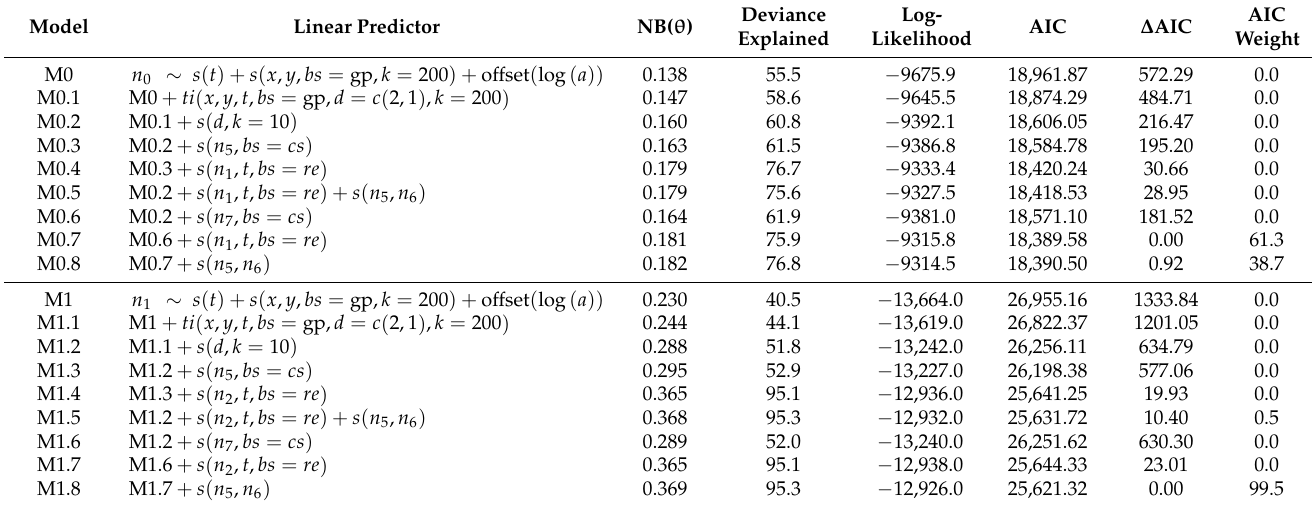
Table 2. Models evaluated to explain the number of Chilean hake juveniles of age groups 0 ( n 0 ) and 1 ( n 1 ), during the austral winter, between 1997 and 2018. The GAM model considered the negative binomial distribution and link log. The number of age 7 (n 7 ) is the number per unit area of 7-year-old and older adult hake. The nomenclature is t = year, x = longitude, y = latitude, a = swept area, and d = bottom depth. The GAM smother terms are explained in the text, and NB( θ ) is the estimated dispersion parameter of negative binomial distribution. The selected model is M07 and M1.8 according to the Akaike’s Information Criterion